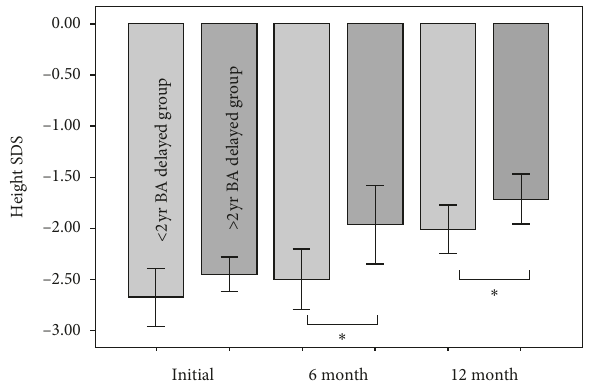
Figure 2: Significant changes in height standard deviation scores (SDS) at the 6-month and 12-month follow-up in the two groups based on bone age delay ∗ p < 0 .